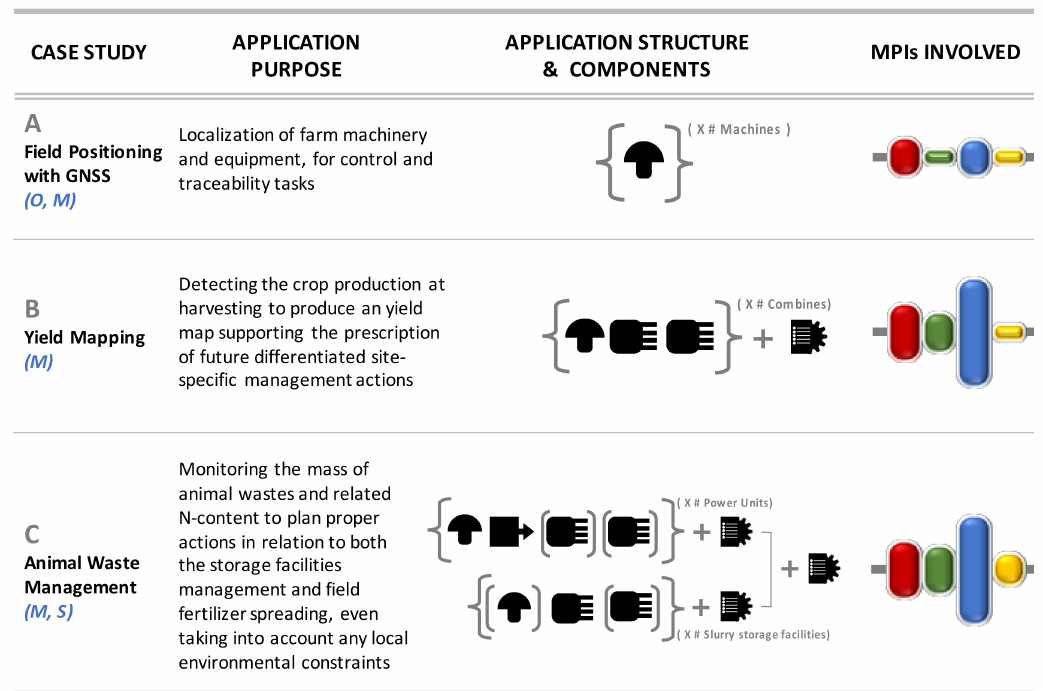
Figure 7. Summary of the case studies discussed here below. For component symbols, refer to Figure 2. Brackets “{ }” indicate whole data acquisition systems to be installed in quantities equal to the number of agents (tractors, combines, storage units etc.) to be monitored at the farm. Parenthesis “( )” indicate optional components (in case C, e.g., they can refer to sensors for detecting the tractor engine rpm or slurry electrochemical conductivity to provide more monitoring details in case of Field Operation Register Keeping (FORK) or slurry storage units,